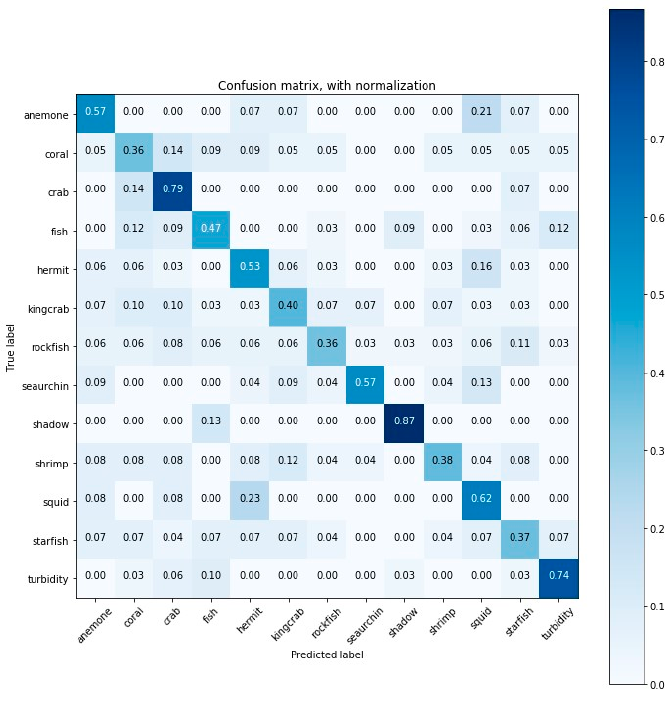
Figure A6. Confusion matrix for the classification results (accuracy) obtained by DT-2. Sensors 2020 , 20 , 726